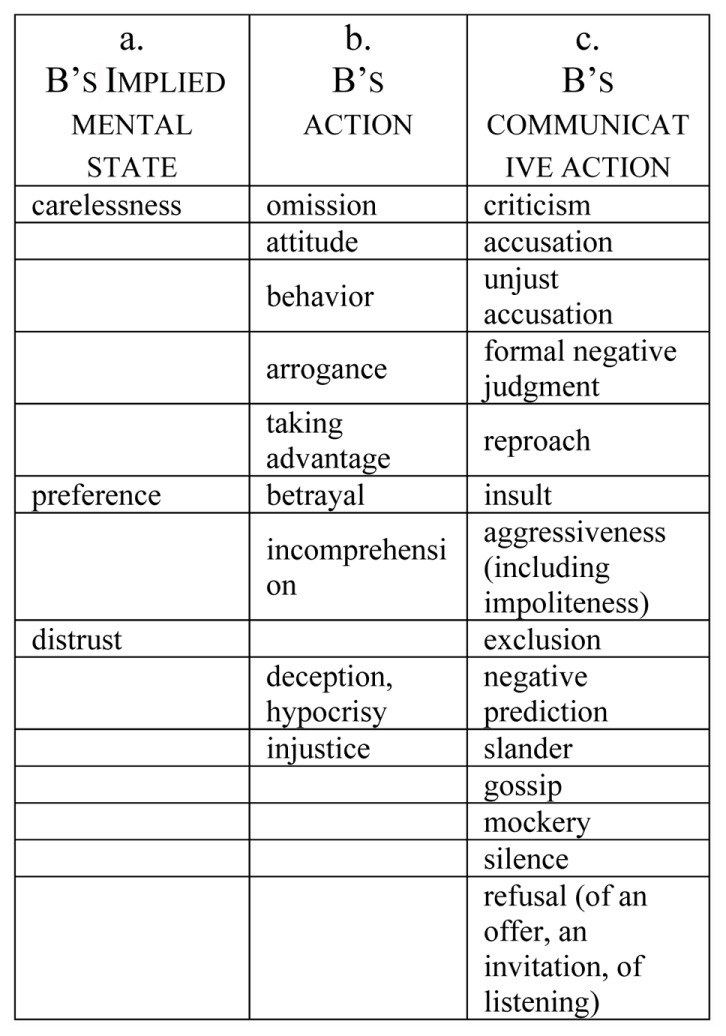
Causes of offense.